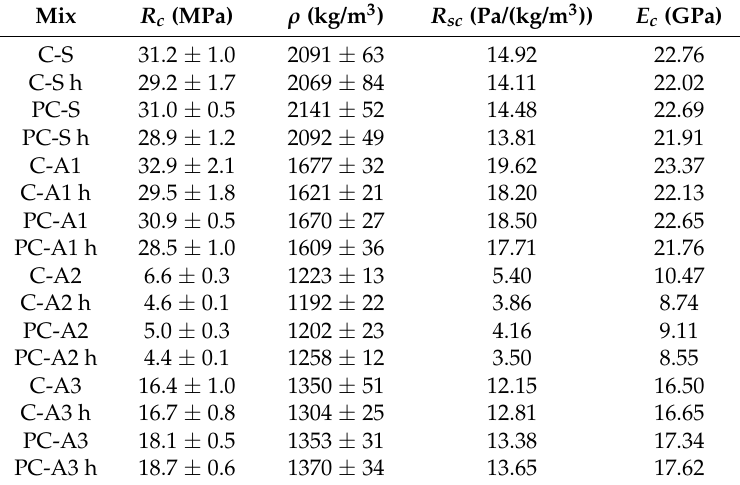
Table 3. Mechanical properties of mortars: compressive strength ( R c ), hardened density ( ρ